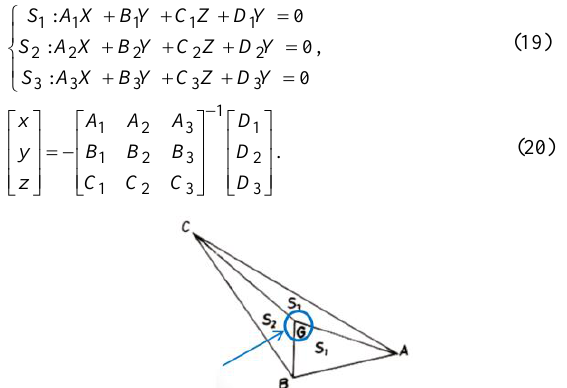
Figure 2: Three adjacent planes and their intersection Building outlines can be determined using labelled parcels of building detection. In this way, the extracted outline is so noisy with high perturbation. Some methods like RANSAC and Hough can be used to fit a line on noisy node. But using these methods cause to lose some edges as noisy data. Also, the base line can be fitted wrongly because of existence of too much noise on the detected outline. Hence, in this study, the bottom plane of roof is detected (Figure 3) and intersection between this plane (red plane) and other planes (green and blue planes) is computed (Figure 3) by using Eqs. (19) and (20) in order to determine the